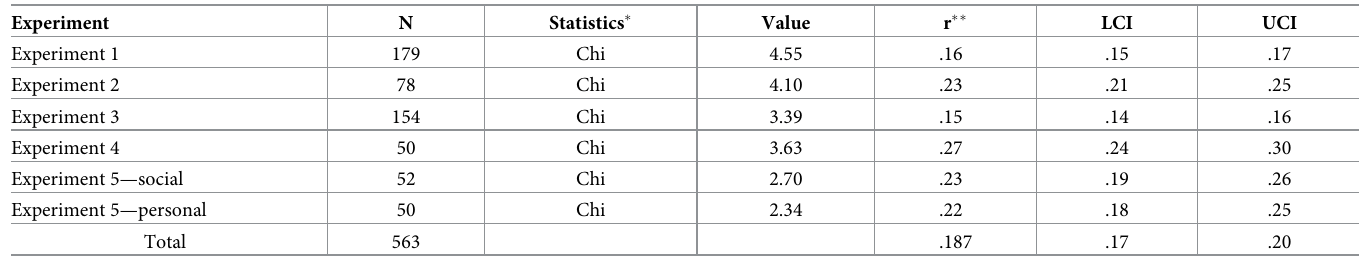
Table 2. Experiments included in the internal meta-analysis.